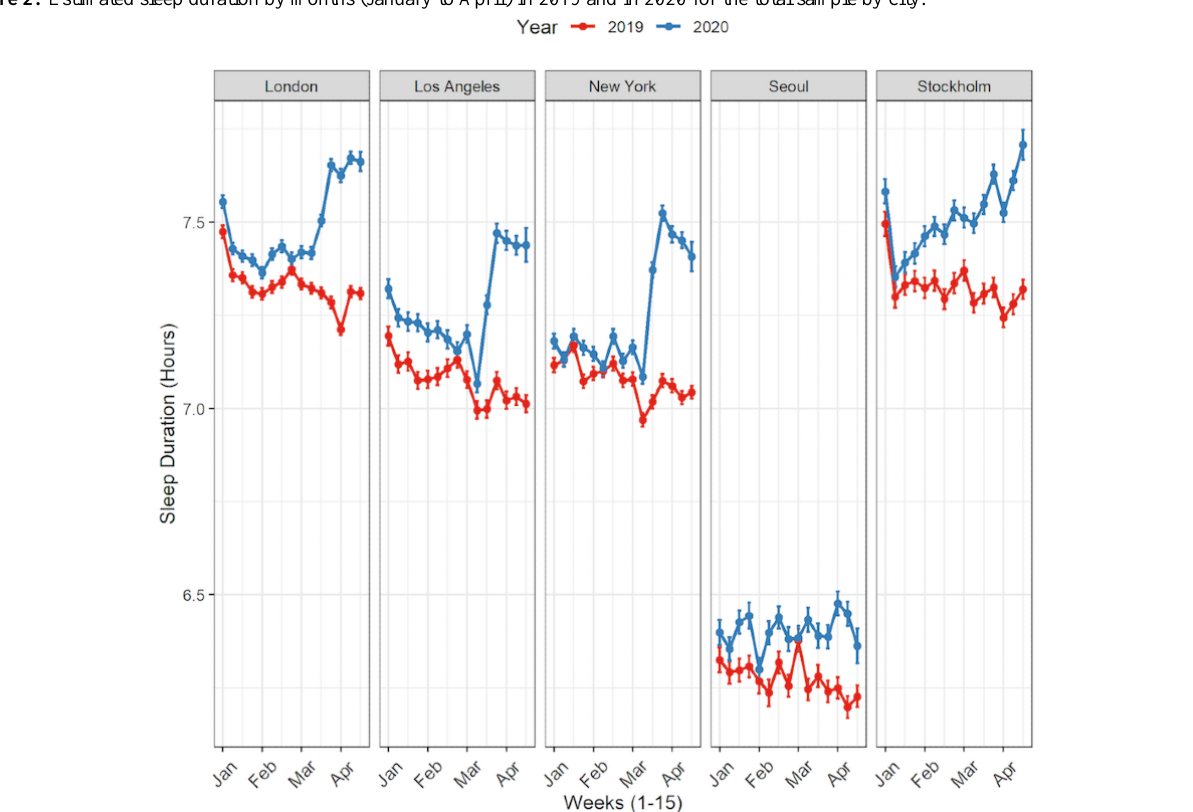
Results from the generalized linear mixed models are